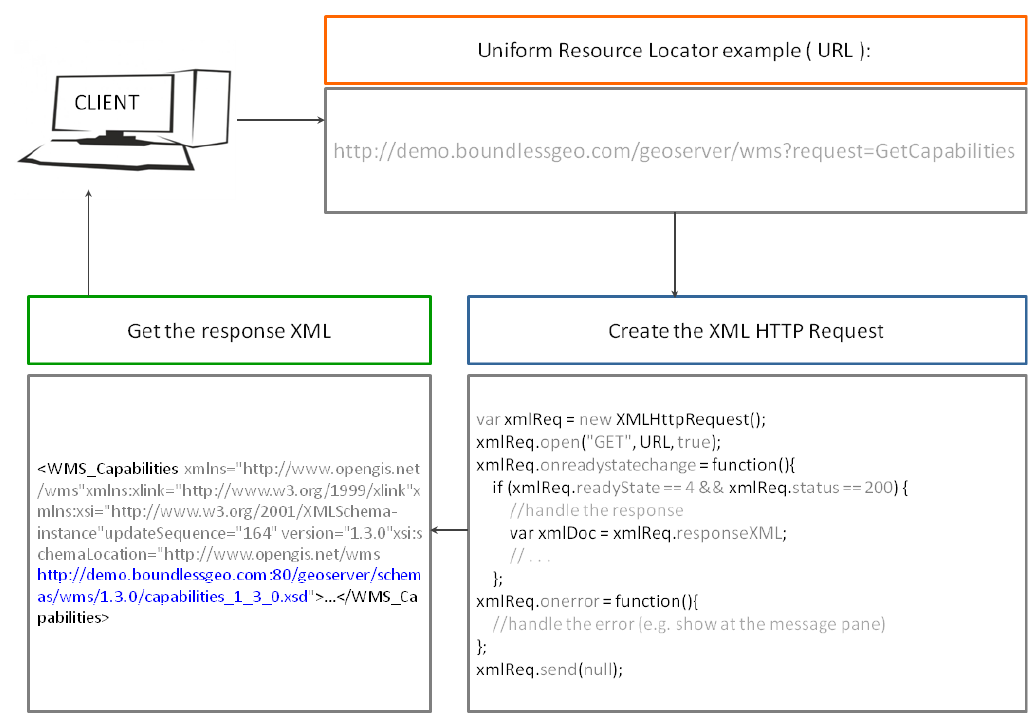
Figure 2. Requesting a web map service (WMS)/GetCapabilities request and receiving the XML response.